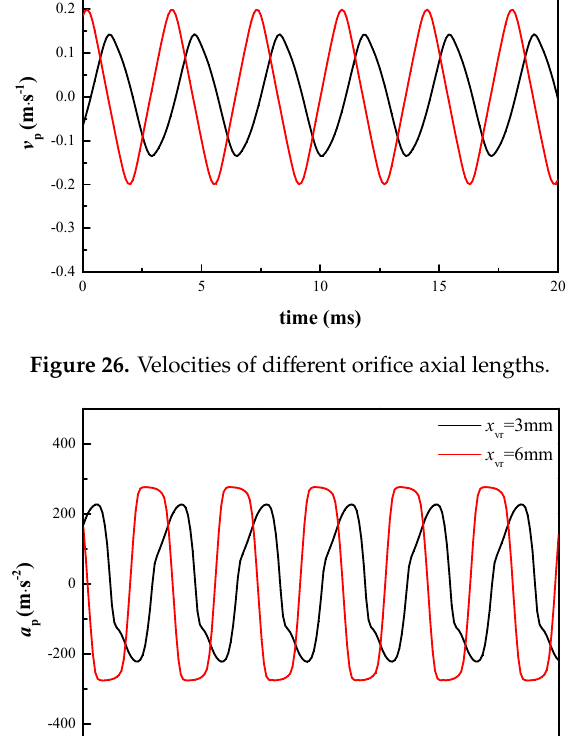
Figure 25. Displacements of different orifice axial lengths.